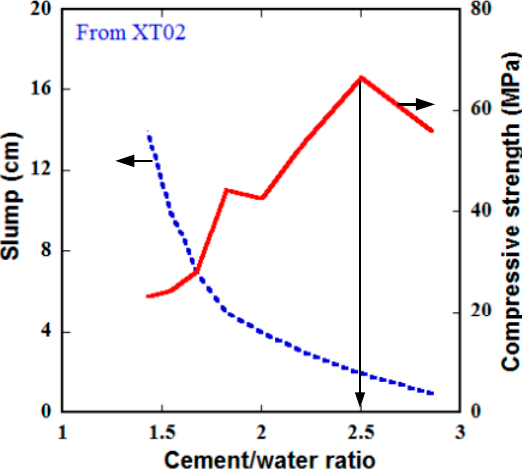
Table 9. Compressive strength and slump with various amount of water at the 28-day age.